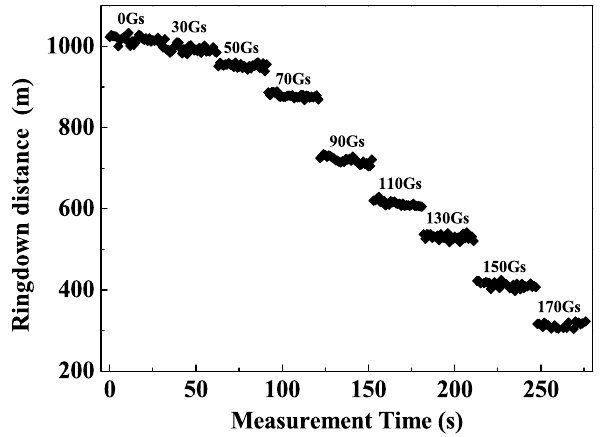
Figure 6. Ringdown distance versus magnetic field strength.